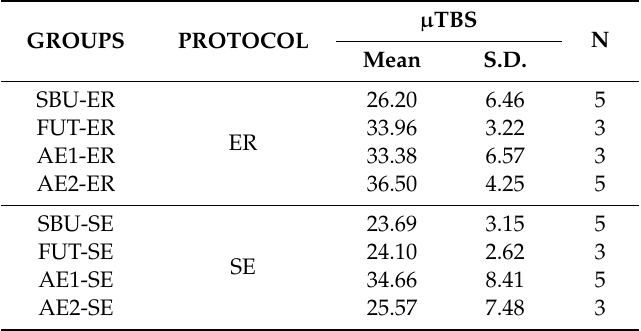
Table 2. Mean values and standard deviations (S.D.) of the dentin micro-tensile bond strength ( µ TBS, in MPa) for the tested